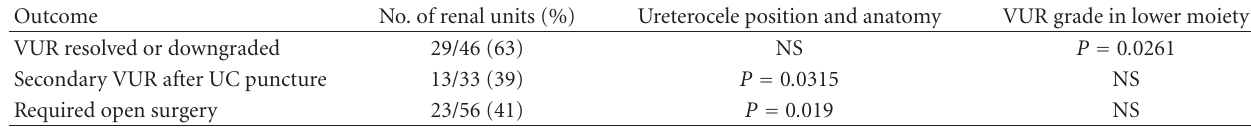
Table 2: Factors a ff ecting the outcome of the all-endo approach and the need for secondary surgical intervention. Outcome